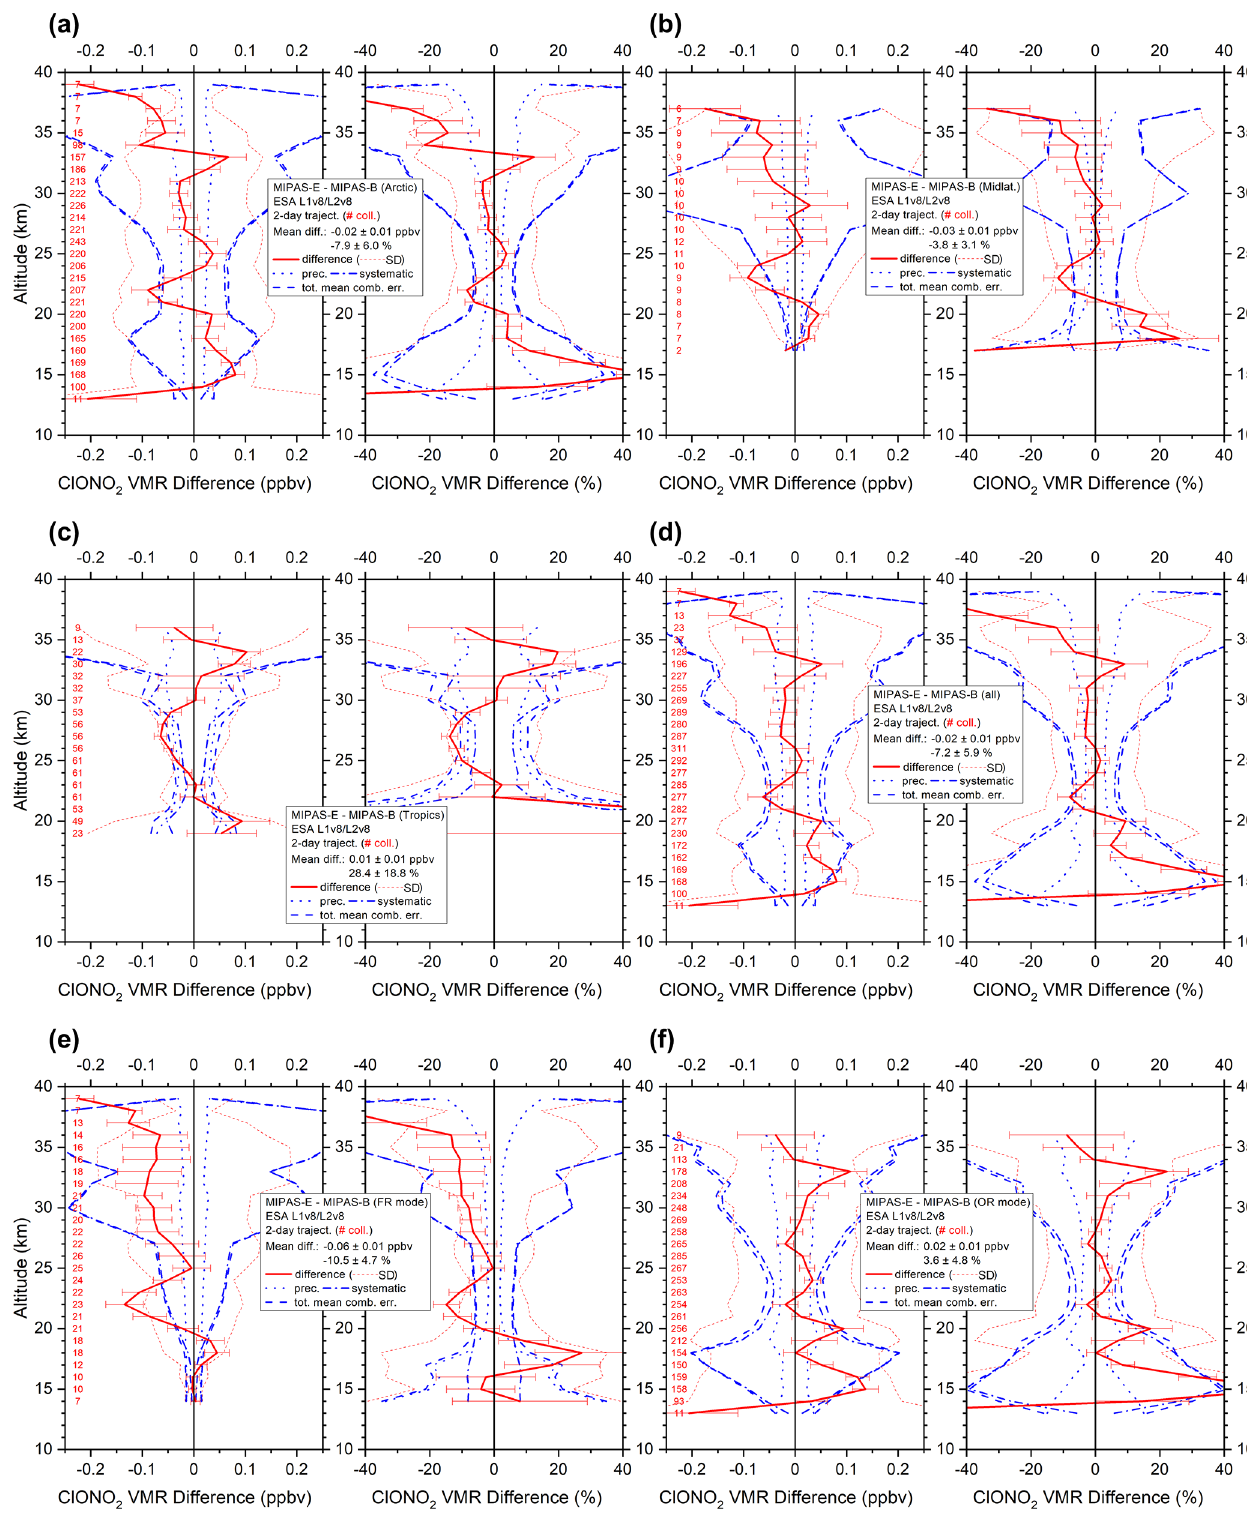
Figure 10. Same as Fig. 3 but for ClONO 2